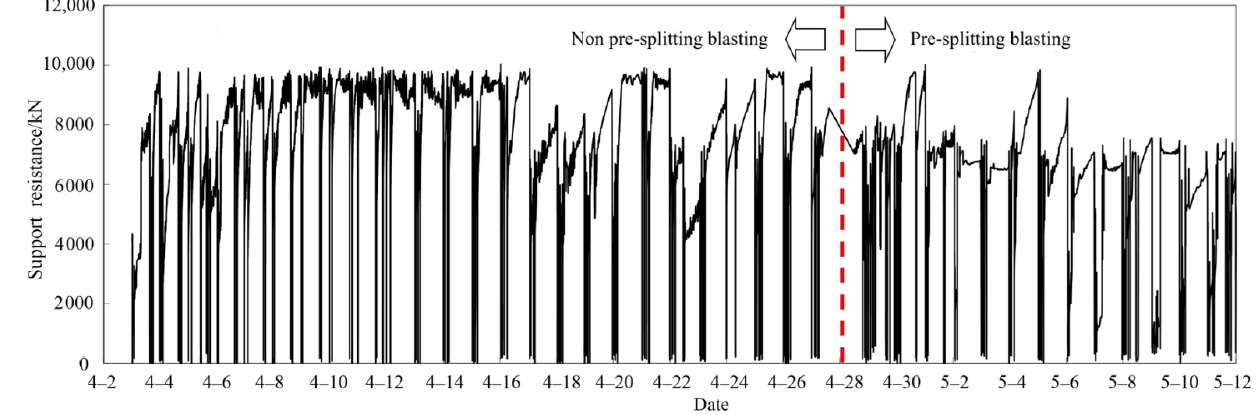
Figure 15. Pressure curve before and after pre-split blasting. Table 5. Comparison of pressure characteristics before and after pre-split blasting.